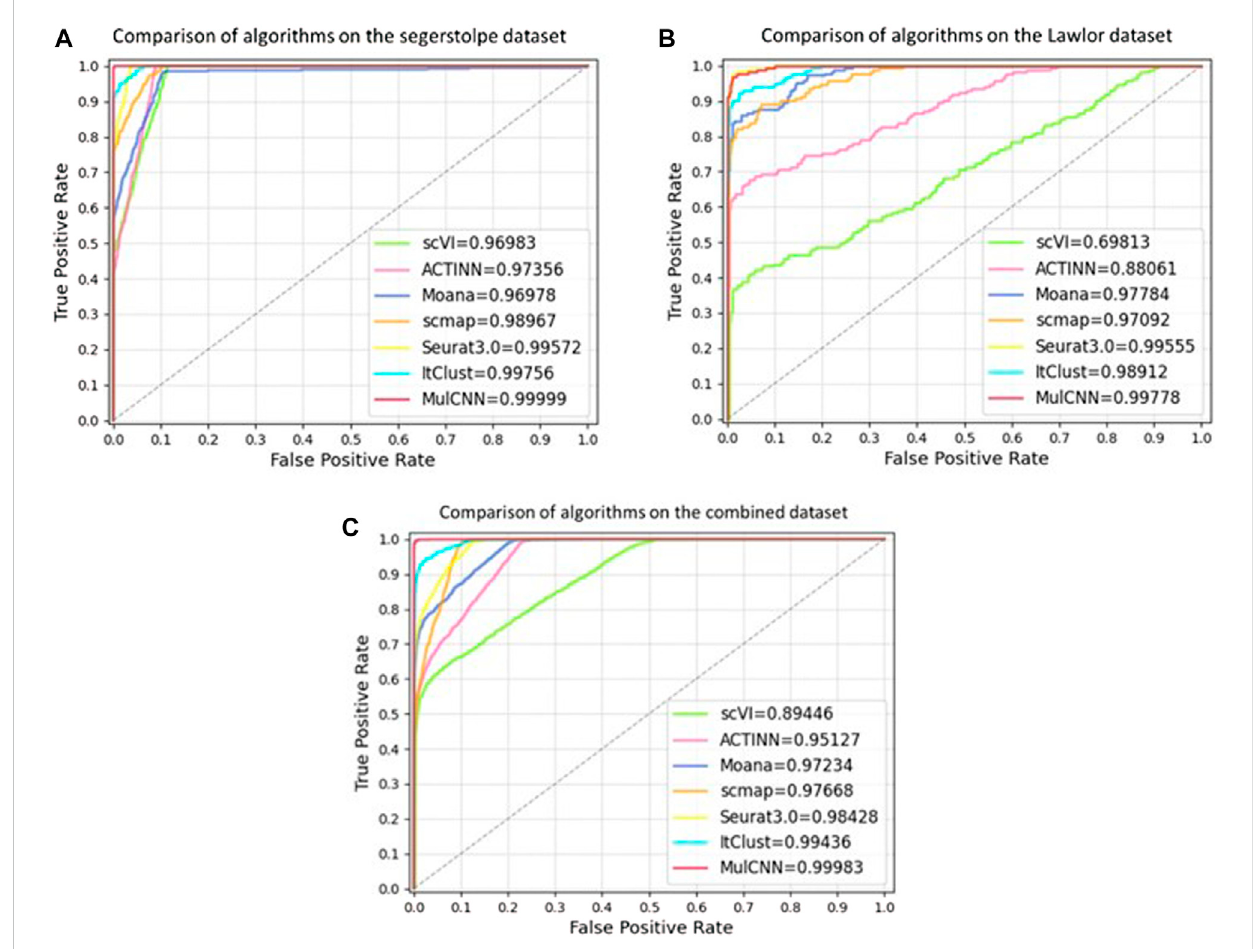
FIGURE 7 ROC curve of different models. (A) Comparison of ROC curves of algorithms on seger-stolpe dataset; (B) Comparison of ROC curves of models on Lawlor dataset; (C) Comparison of ROC curves of models on combined